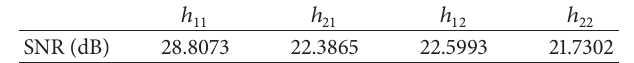
Table 1: Average SNR of the estimates of H 0